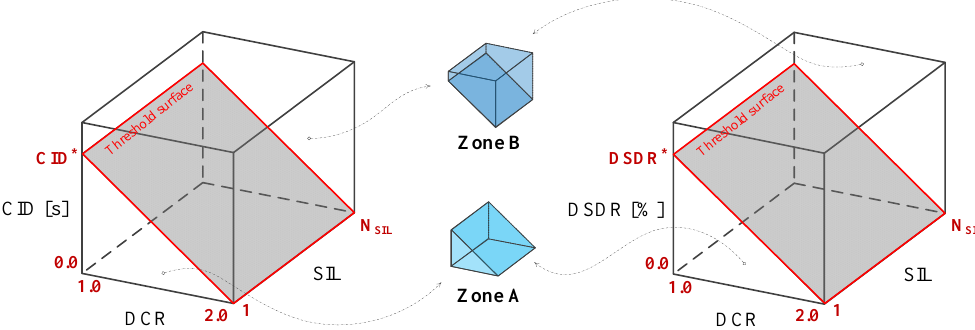
Figure 1. Seismic performance evaluation of arch dams based on linear